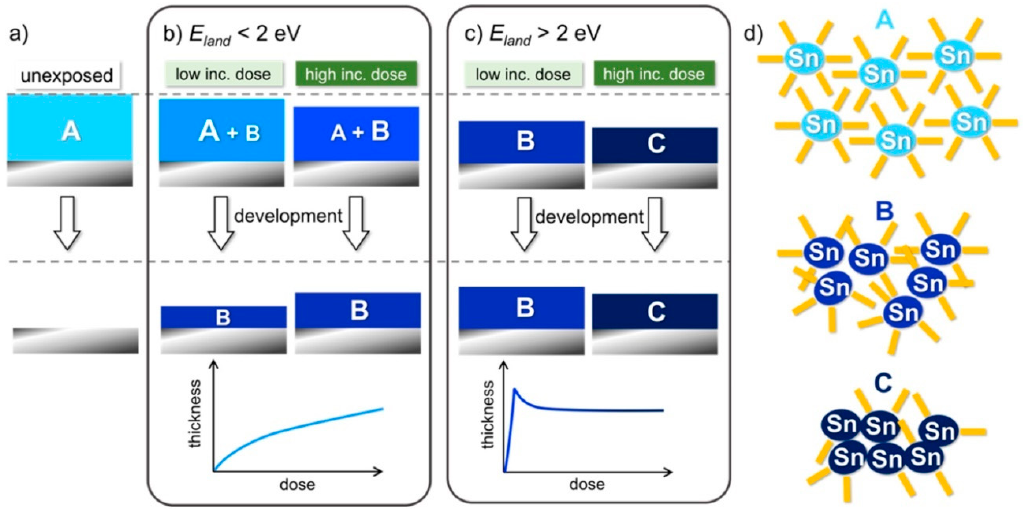
Figure 9. Scheme representing the patterning of the Tin-OH material. ( a ) The unexposed resist is removed completely during the development. ( b ) For electron exposure with E < 2 eV, only a small fraction of electrons impinging on the surface reach the material and only low conversion is attained. ( c ) For E > 2 eV, as the incident dose increases, consecutive reactions lead to the insoluble products B (denser than A) and C (denser than B). ( d ) Schematic representation of the initial Tin-OH molecular material A and of the two insoluble networks B and C. Blue ellipses represent the Sn-based inorganic core and orange bars the butyl chain. Adapted from [40] (https://pubs.acs.org/doi/10.1021/acsami.9b19004), with permission from American Chemical Society, 2020.